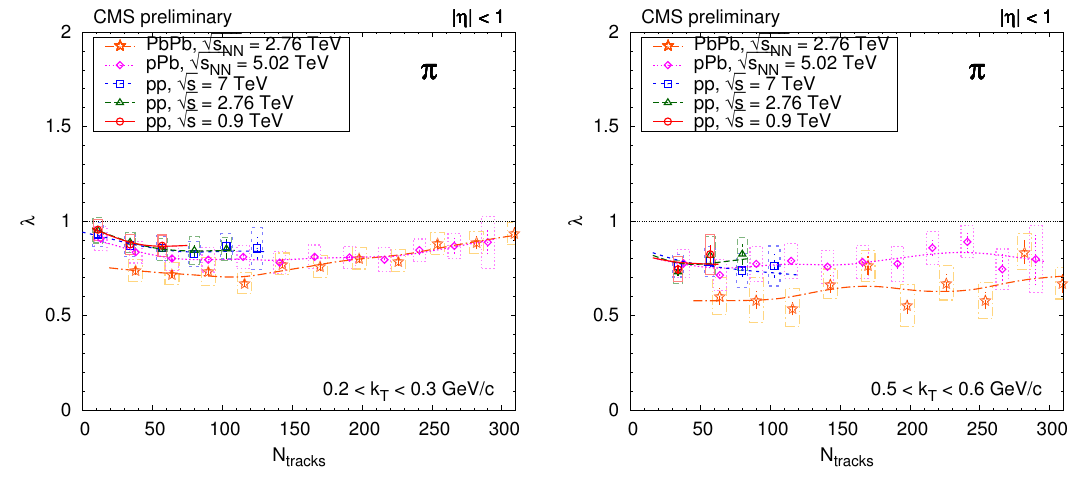
Figure 5. The N tracks dependence of the one-dimensional pion radius ( Top ) and the one-dimensional pion chaoticity parameter ( Bottom ), shown here for several k T bins, for all studied reactions [8]. Lines are drawn to guide the eye.